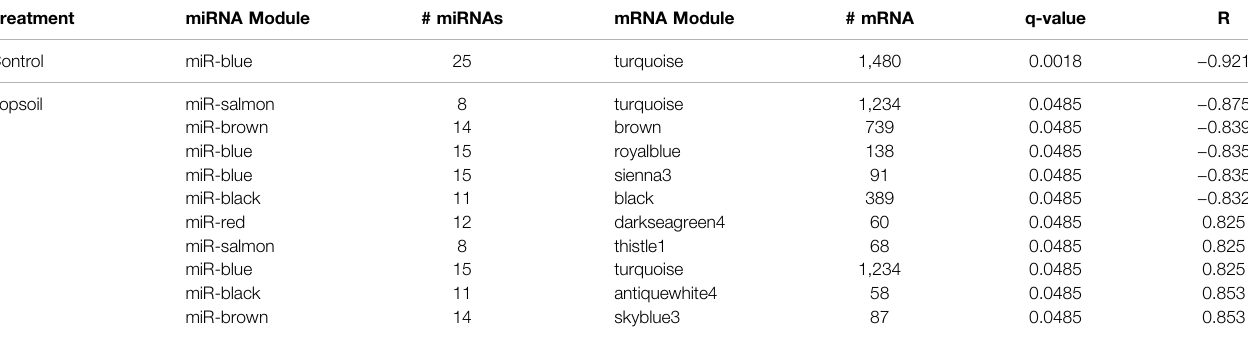
TABLE 1 | Identi fi cation of correlated (q < 0.05) miRNA:mRNA modules. Modules are identi fi ed with colors names designated by WGCNA software within treatment group (topsoilorcontrol).ThenumberofmiRNA(#miRNAs)andmRNA(#mRNA)withineachmodule,correlationbetweenmodulepairs(R),andsigni fi canceofthecorrelation (q-value) are